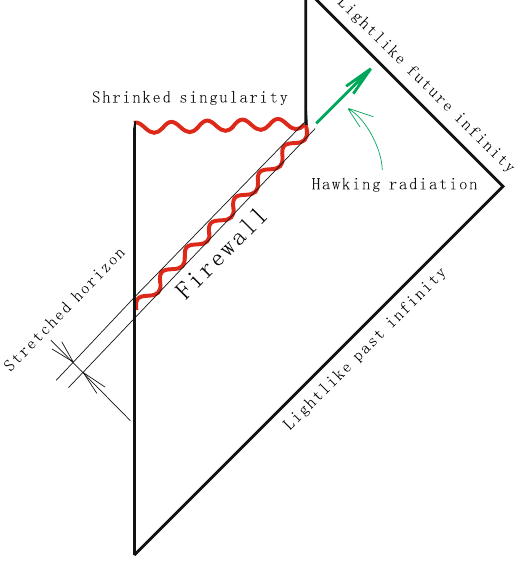
Figure 1. The conceptual Penrose diagram for an old black hole. This diagram shows an old black hole. The naked firewall has been formed around the